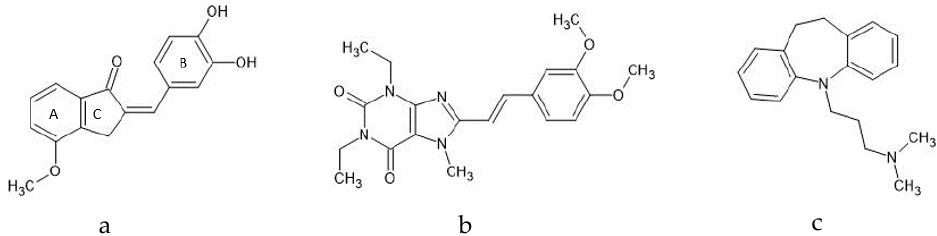
Figure 1. Chemical structures of the test compound ( a ) 2-(3,4-dihydroxybenzylidene)-4-methoxy-2,3-dihydro-1H-inden-1-one (compound 1a ) and reference compounds ( b ) KW-6002 and ( c ) imipramine.